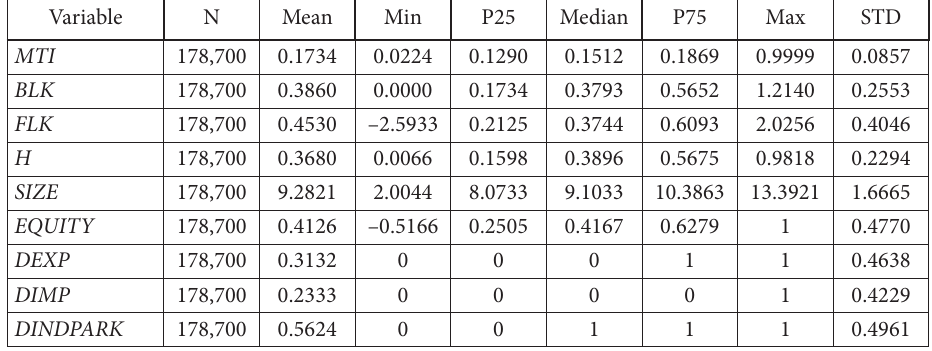
Table 3. Summary statistics for the final sample (source: Vietnam’s GSO and authors’